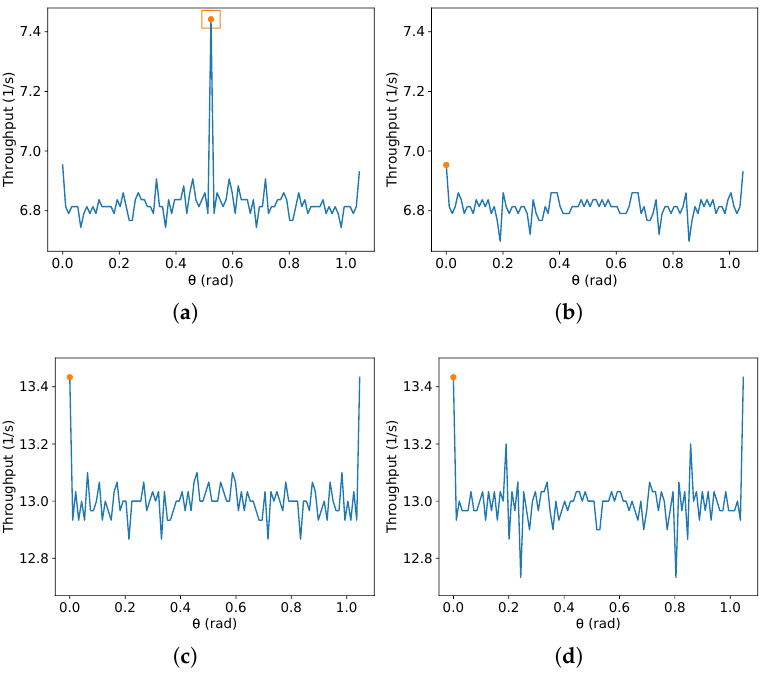
Figure 8. Examples of (9) varying θ from 0 to π for different and randomly generated values of T , s , 3 and d . It continues in Figure 9. ( a ) For 99 samples, T = 43 s, s = 3 m, d = 1 m. ( b ) For 100 samples, T = 43 s, s = 3 m, d = 1 m. ( c ) For 99 samples, T = 30 s, s = 2.5 m and d = 0.66 m. ( d ) For 100 samples, T = 30 s, s = 2.5 m and d = 0.66 m.